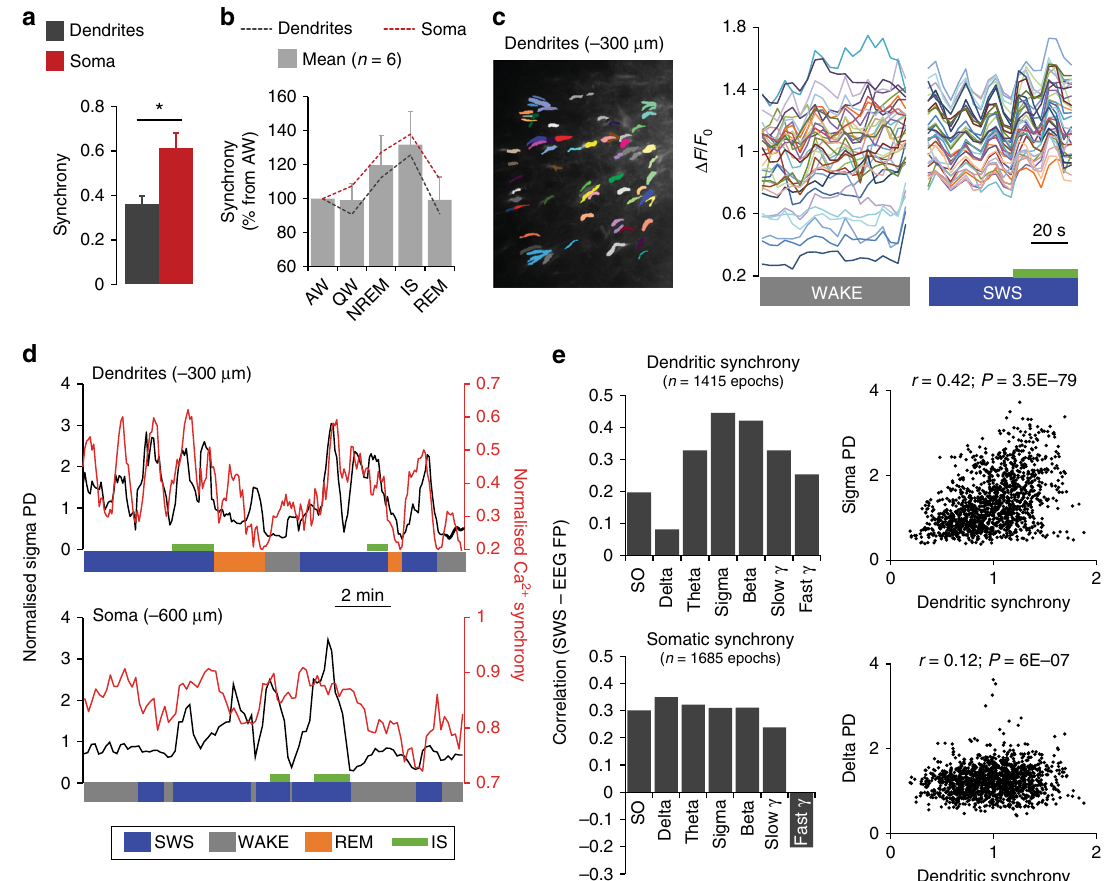
Fig. 6 Spindle – beta oscillations re fl ect increased dendritic Ca 2+ activity synchronisation. a Average Ca 2+ activity synchronisation in dendrites and somata across all behavioural states ( H = 7.1, P = 0.008 Kruskal – Wallis one-way ANOVA on ranks; * P < 0.05, Dunn ’ s test). N = 15/group (5 states/mice, 3 mice/ group). b Synchronisation of Ca 2+ activity in dendrites and somata of L5 neurons across behavioural states (expressed as percentage of respective AW value for each animal, n = 11/group). For a , b , values represent means ± s.e.m. c Example of synchronisation of Ca 2+ activity ( Δ F / F 0 ) of the same 34 dendrites (imaged at − 300 µ m) during SWS compared to WAKE. IS is represented by the green bar . d Examples of changes in sigma PD and Ca 2+ activity synchronisation for recordings from dendrites of L5 neurons ( upper graph ) and L5 somata ( lower graph ). e Correlation (Pearson) coef fi cient between dendritic ( upper graph ) and somatic ( lower graph ) synchrony of Ca 2+ activity and different frequency bands (EEG-FP). N = number of SWS epochs used for correlations (values from the three animals in each group were pooled). Corresponding scatter plot for dendritic synchrony and sigma and delta band are represented. For c – e , values from individual 4 s SWS epochs were used for